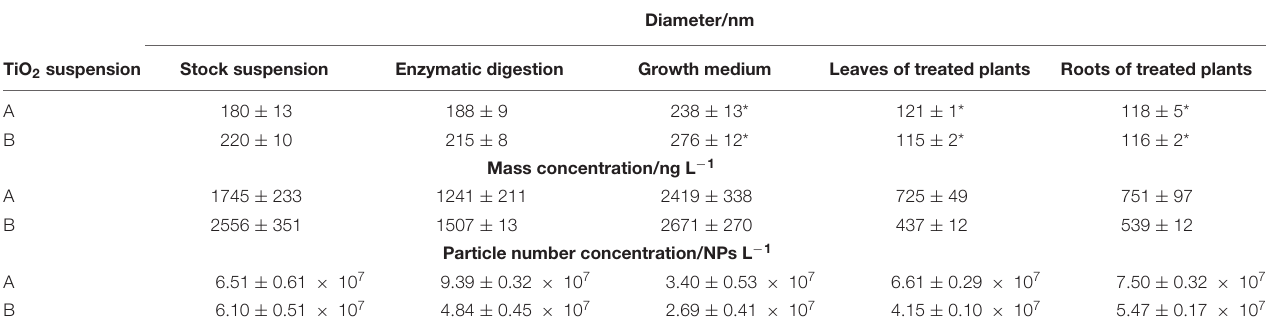
TABLE 2 | Median diameters, particle number concentrations, and mass concentrations obtained by SP-ICP-MS for the analysis of stock TiO 2 NP suspensions, the same nanoparticle suspensions after 7 days in contact with the growth medium, after enzymatic digestion procedure and extraction from plant tissues.